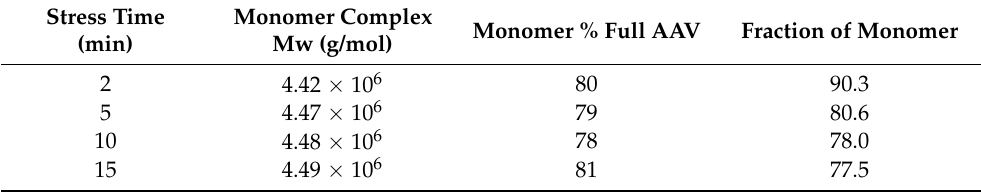
Figure 6. RI detection chromatograms of full rAAV5 samples incubated at 45 °C and aliquoted at 2, 5, 10, and 15 min for analysis by SEC–MALS. Table 5. Effect of thermal stress on monomer fraction and percentage of full rAAV5 sample deter- mined by SEC–MALS.